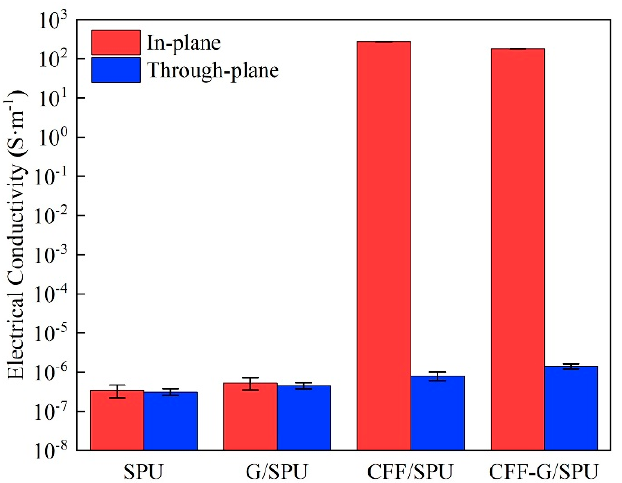
Figure 6. In-plane and through-plane electrical conductivities of SPU, G/SPU, CFF/SPU and CFF- G/SPU.